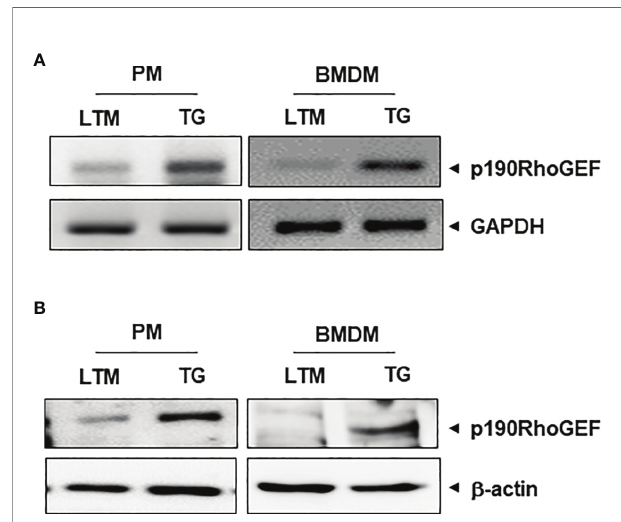
FIGURE 1 | p190RhoGEF transgene expression in TG macrophages. (A) mRNA transcripts of p190RhoGEF in PMs and BMDMs from LTM and TG mice. GAPDH was used as a control. (B) Expression analysis of p190RhoGEF protein in PMs and BMDMs from LTM and TG mice. Actin was used as a control. All data are representative of three separate